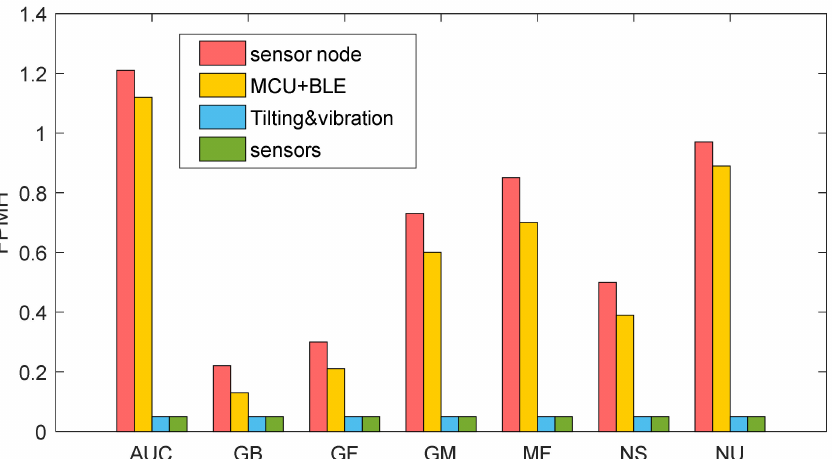
Figure 9. Expected number of failures for each individual subsystem (module) composing the sensor node under the ‘on demand’ METERING operating condition and considering the working environments previously listed. Red bars: failure rates of the whole sensor node; orange bars: failure rates of MCU + BLE module; blue bars: failure rates of tilting and vibrations module; green bars: failure rates of the sensors